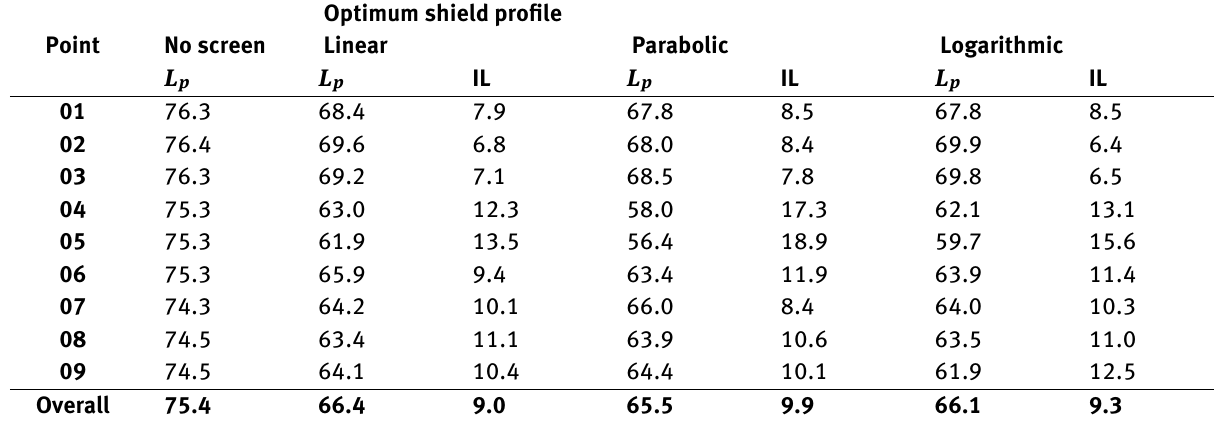
Table 5: Sound pressure level with and without noise screens: Receiver 02. All values in dB(A) Optimum shield profile